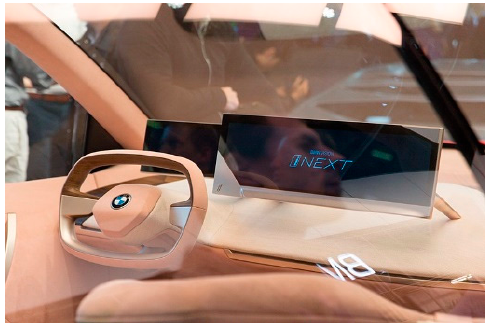
Figure 2. iNEXT-COPILOT system [4].